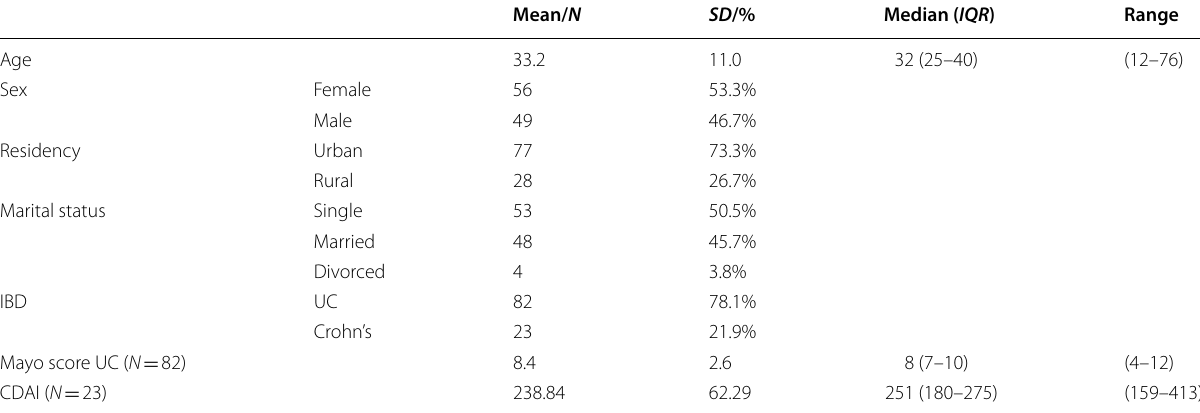
Table 1 Characteristics of the patient population